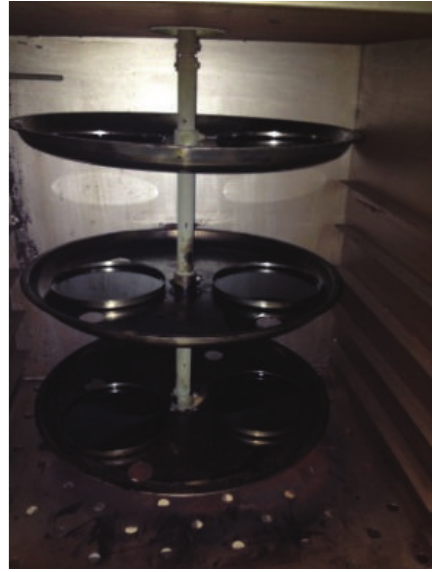
Figure 2: Process of